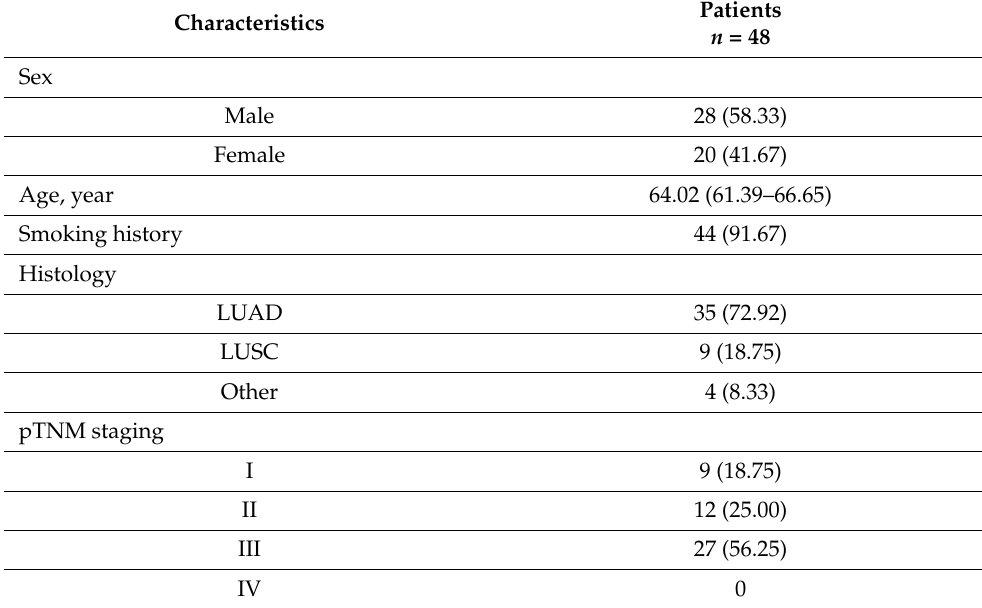
Table 1. Patient’s